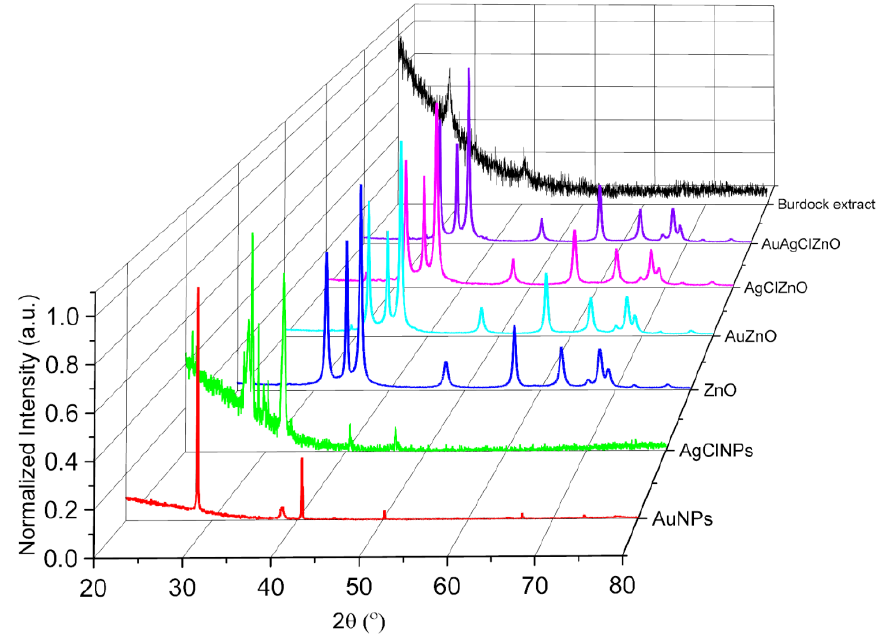
Figure 4. XRD patterns of the samples.